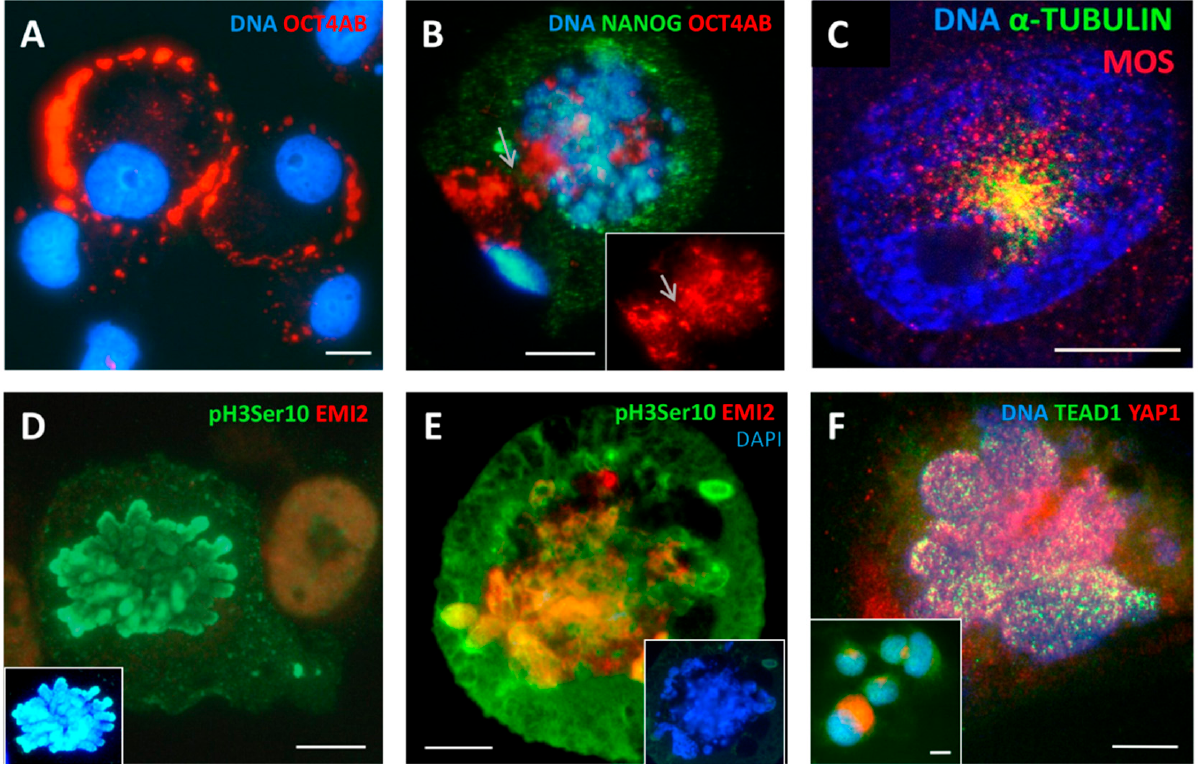
Figure 7. Cell fate change during MS where maternal germline specification and the inactivation of the Hippo pathway are observed on days 4–5 post DOX treatment: ( A ) OCT4-antibody-positive cells in NT control showing the cytoplasmic location of OCT4B; ( B ) the entrance of OCT4A into the cell nucleus (likely from the centrosome pole, arrowed) during MS; ( C ) the meiotic kinase MOS and α -TUBULIN form a monopolar spindle (arrowed) in the early prophase; ( D ) mitotic marker pH3ser10-positive and EMI2-negative metaphase in NT control; insert: metaphase-pH3ser10 with DAPI; ( E ) the chromosomes swelling and fusing in MS while losing the pH3Ser10 label become positive for EMI2 (insert: only DAPI staining); ( F ) the inactivation of the Hippo pathway, with the transition of YAP1 in its active form along with MS from the cytoplasm into the cell nucleus and interacting there with its partner transcription factor TEAD1 (insert: NT control cells). Imaged in RGB optical filters. Bars = 10 µm. Figure 7C is republished from [4] with an open access CC BY 4.0 license.